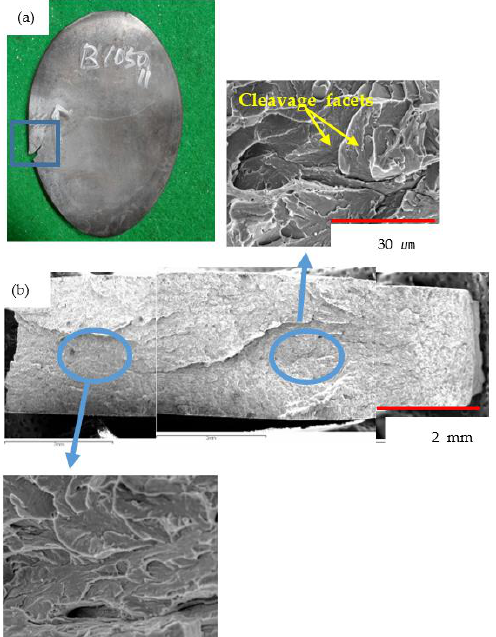
Figure 3. Alloy B steel during the rolling process under the tempering condition after the normalization: ( a ) fractograph of failed part and ( b ) scanning electron microscopy (SEM) image.